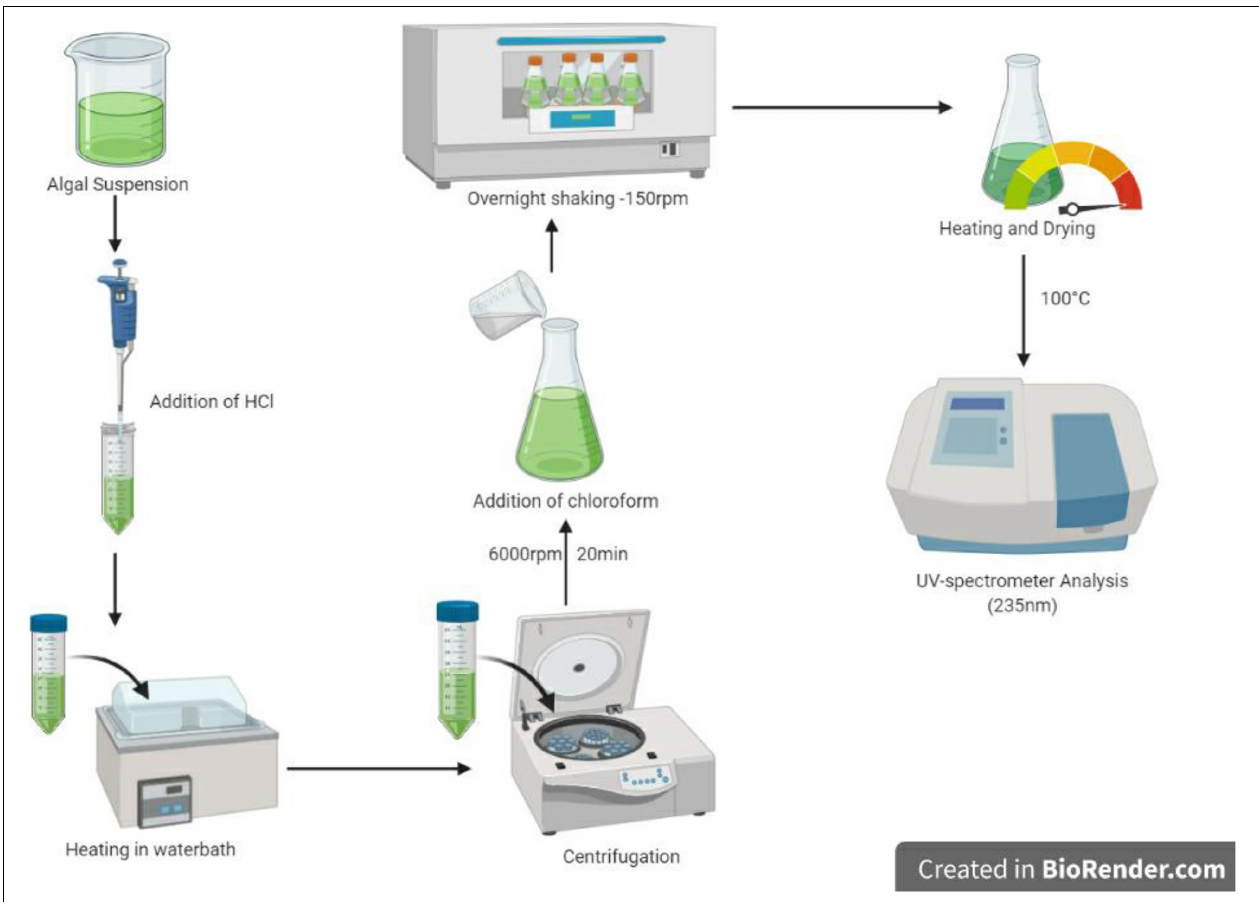
FIGURE 3 | Steps for extraction of